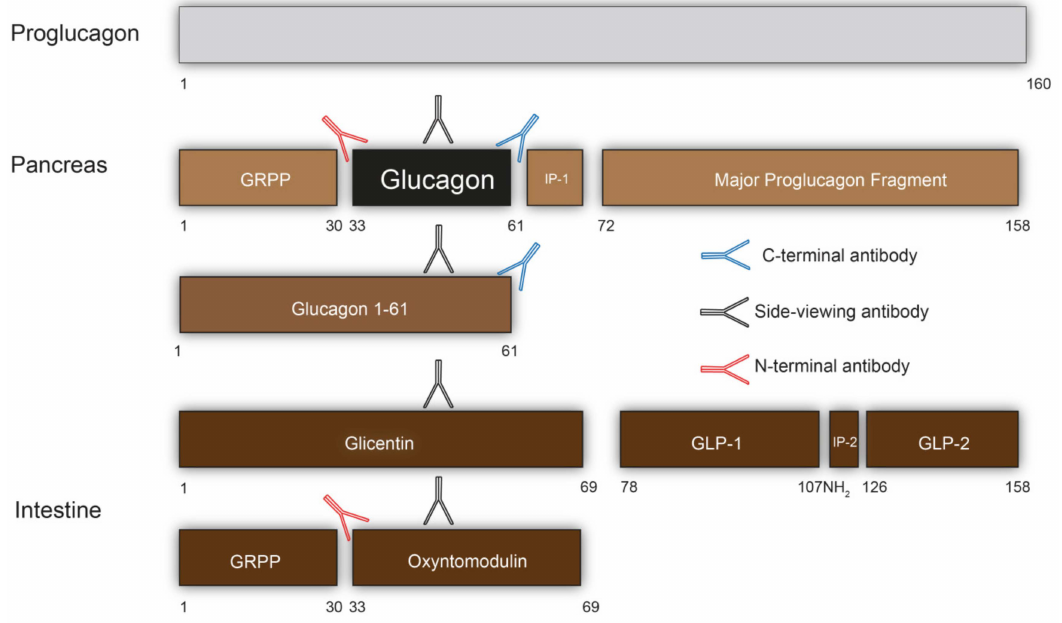
Figure 1. Proglucagon processing and measurement of glucagon by antibodies. The numbers refer to the numbering of the residues in proglucagon. Glucagon 1–61 may also be formed in the